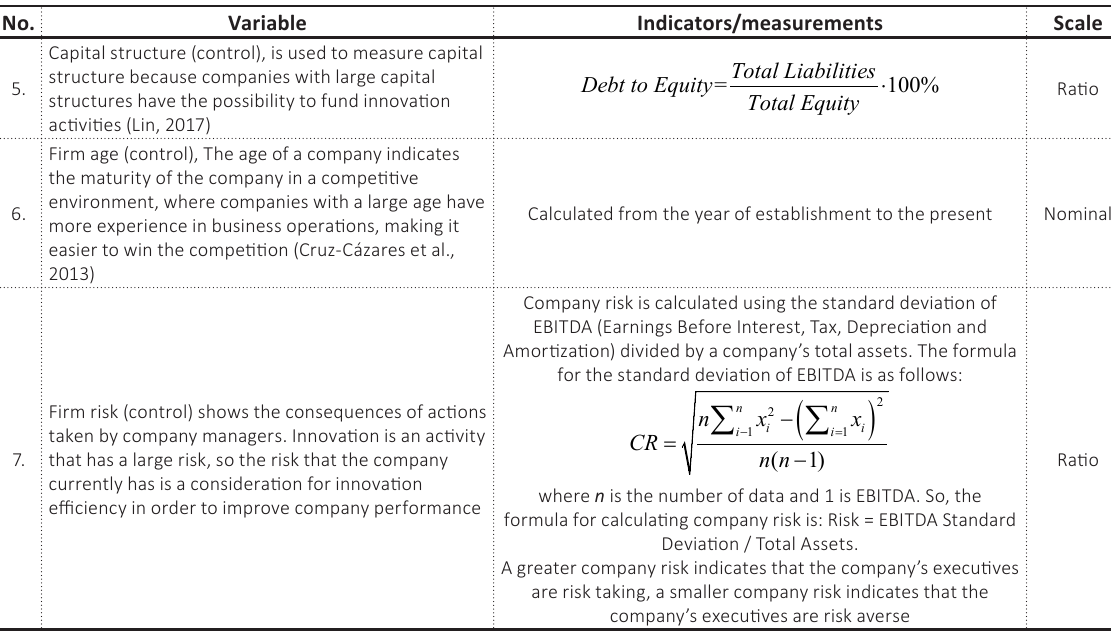
Table 1 (cont.). Definition and measurement of research